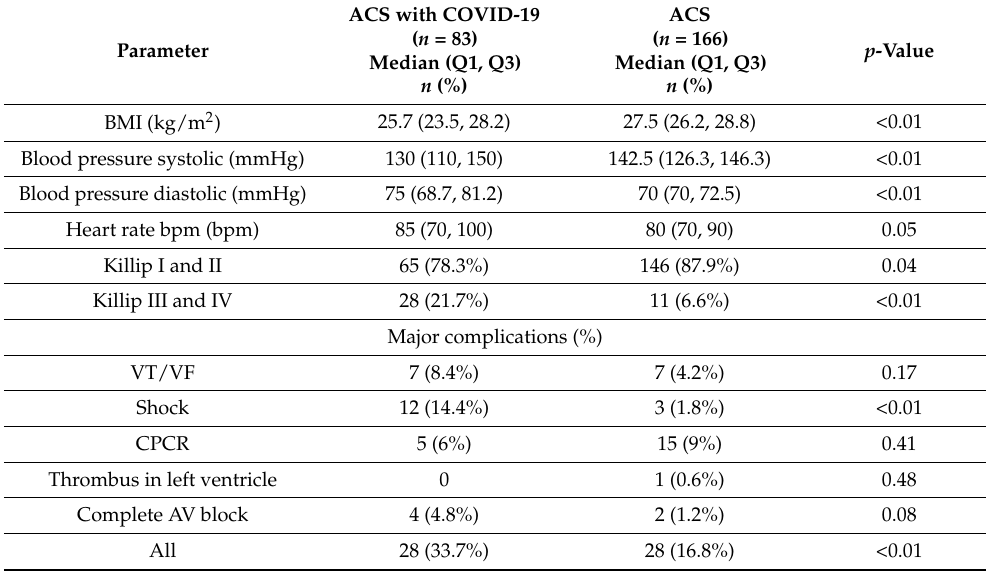
Table 2. Patients’ clinical examination characteristics on admission and major complications between groups.